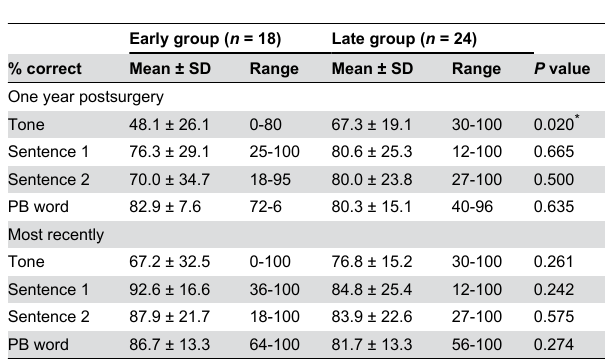
Table 7. Comparison of speech perception test scores obtained one year after implantation and most recently between the early and late groups.